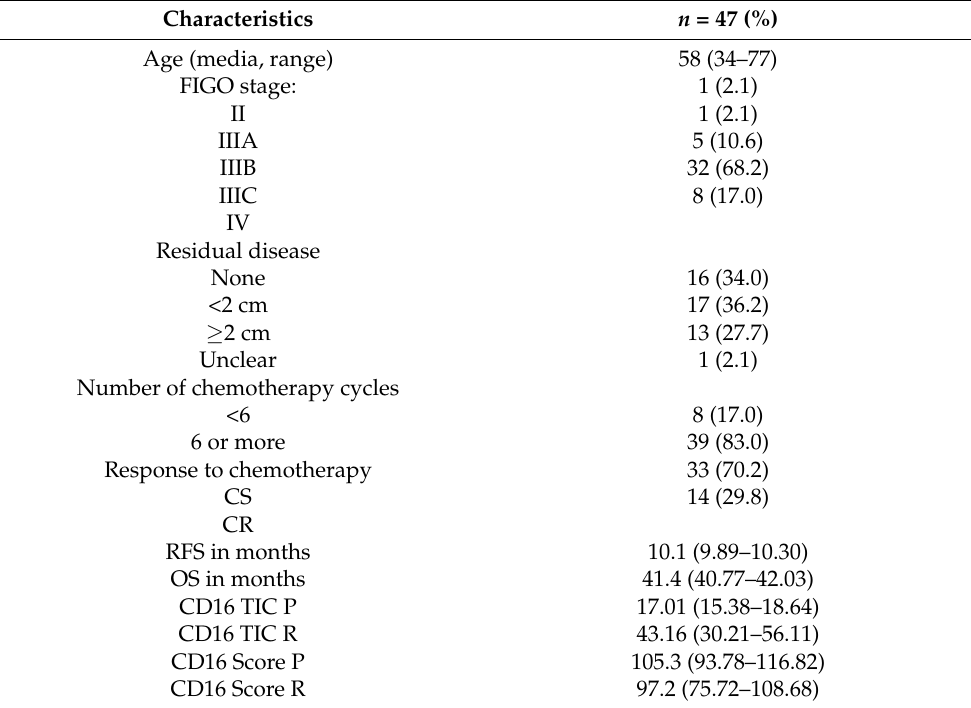
Table 1. Patients’ characteristics of overall cohort ( n =